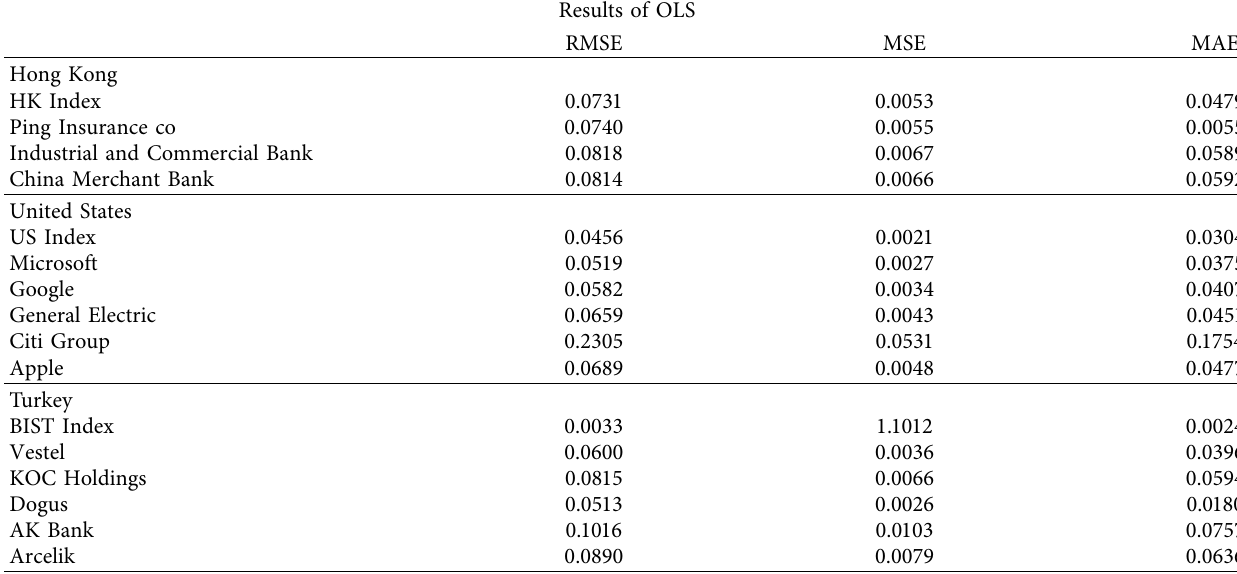
Table 13: Results of OLS method for all companies of Hong Kong, US, and Turkey without